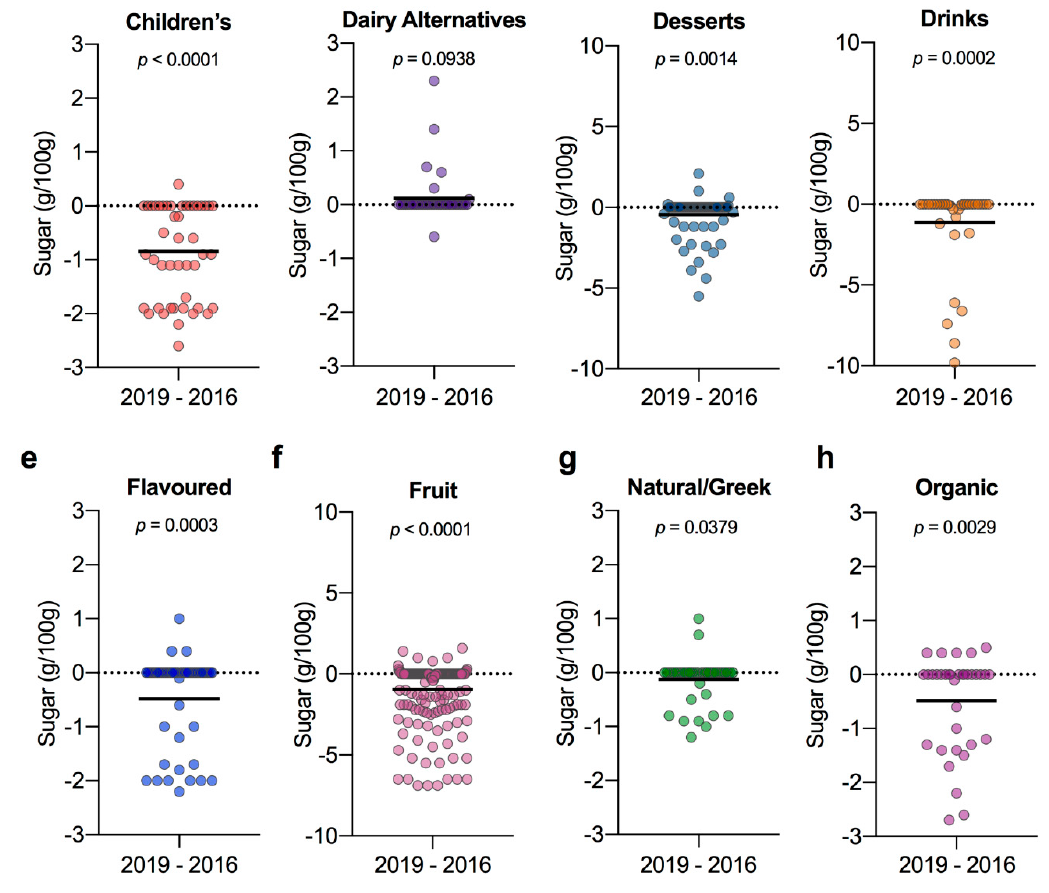
Figure 2. Difference plots for each category showing the change in total sugar content between yogurt products sold both in 2019 and 2016. ( a ) Children’s ( n = 46); ( b ) dairy alternatives ( n = 39); ( c ) desserts ( n = 77); ( d ) drinks ( n = 40); ( e ) flavoured ( n = 60); ( f ) fruit ( n = 195); ( g ) natural/Greek ( n = 47); ( h ) organic ( n = 35). Data were analysed using the Wilcoxon matched-pairs signed-rank test; solid black line indicates mean change between 2016 and 2019.